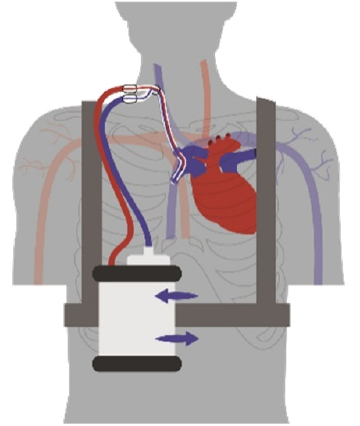
Figure 1. Concept for a portable VV-ECMO system.